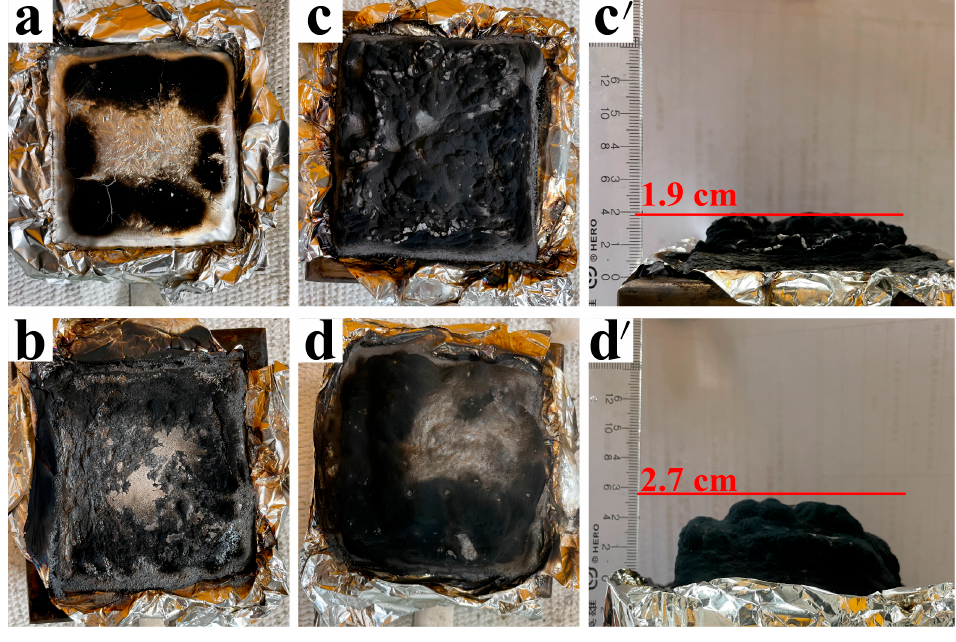
Figure 7. Digital photographs of the char residue of PP0 ( a ), PP1 ( b ), PP3 ( c , c ′ ), and PP6 ( d , d ′ ) after CCT.